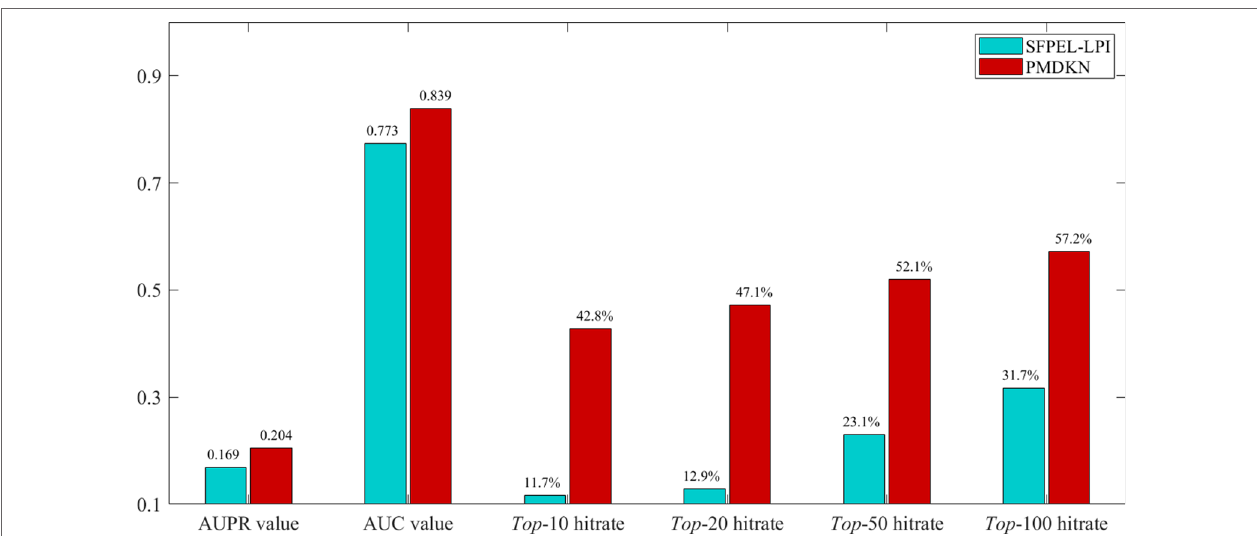
FIGURe 4 | Comparison of SFPEL-LPI and PMDKN prediction results for new proteins. The AUPR and AUC values in the figure represent the average AUPR and average AUC values predicted by PMDKN for 79 proteins, respectively. Top-10 hitrate, Top-20 hitrate, Top-50 hitrate, and Top-100 hitrate represent the mean hit rates of the first 10, 20, 50, and 100 candidate lncRNAs,